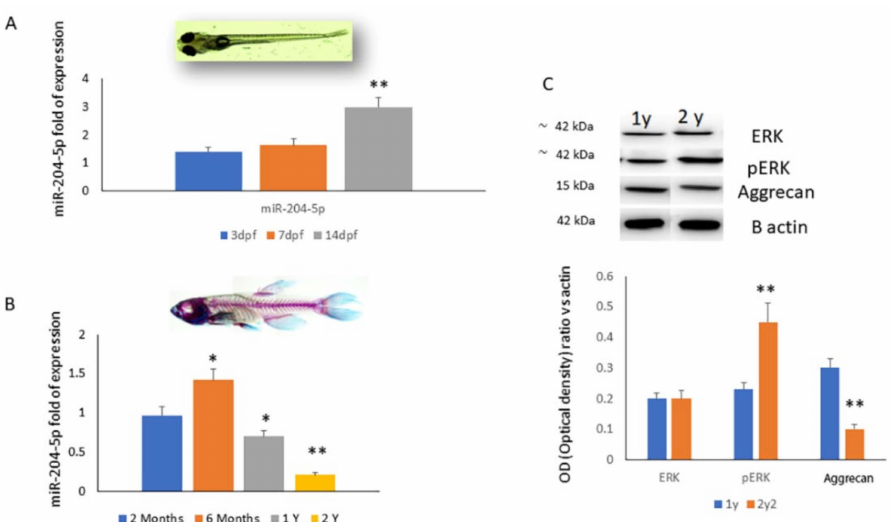
Figure 3. miR-204-5p mRNA expression levels quantified by RT-PCR during ( A ) embryogenesis (3, 7 and 14 days post fecundation (dpf)) and ( B ) aging (2 and 6 months, 1 and 2 years old) in a zebrafish larvae in vivo model. ( C ) ERK, pERK and aggrecan protein levels assessed by western blot (top) and quantified as a relative optical density ratio vs. B-actin (down) on protein lysates from a zebrafish larvae in vivo model. (* p < 0.05; ** p < 0.005 vs. expression levels of larvae after 3 (dpf) ( A , B ) and vs. 1 year old ( C